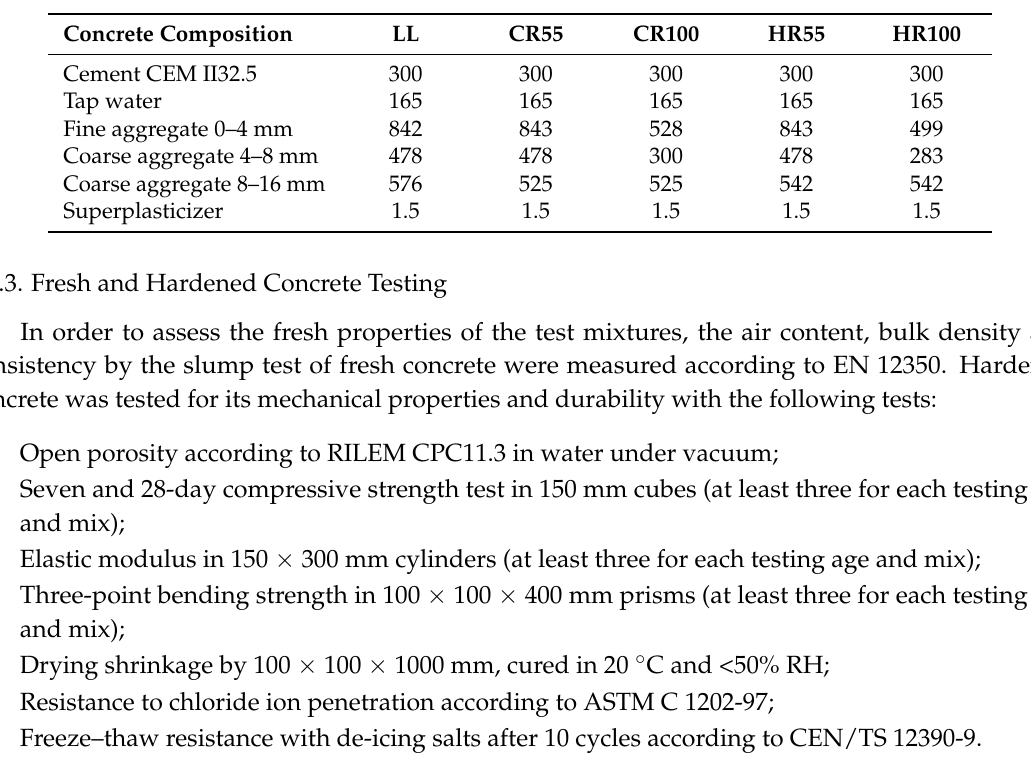
Table 2. Proportions of all mixtures in kg/m 3